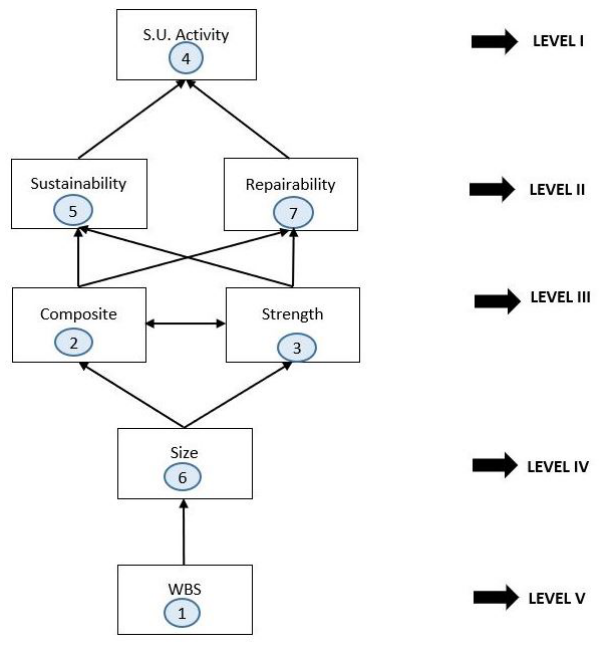
Figure 29. Digraph based on ISM Analysis and Driving Factors.